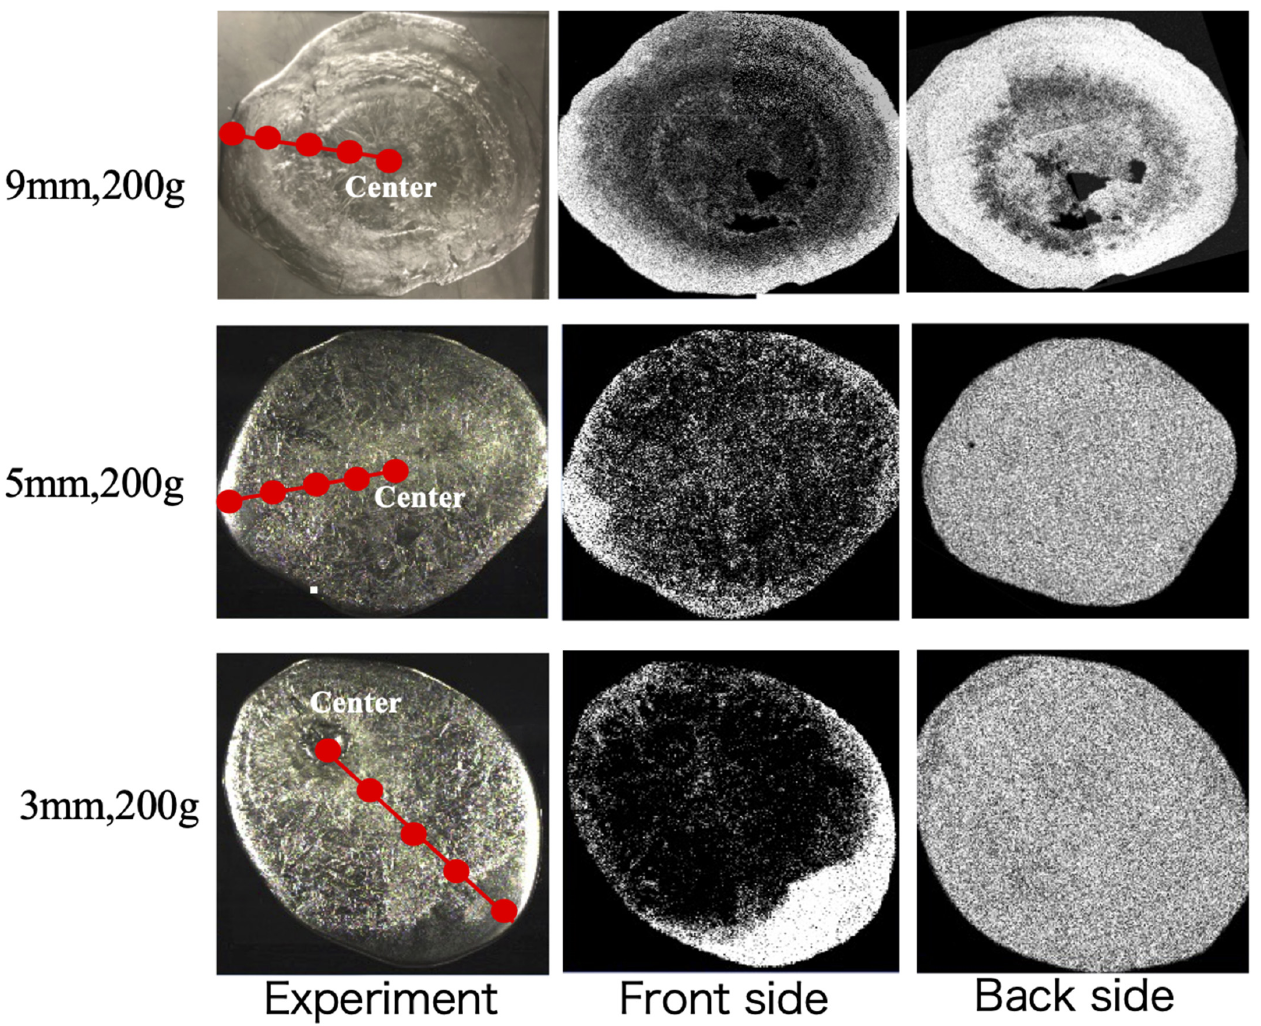
Figure 5. Mapping image analysis results in the density stratification.